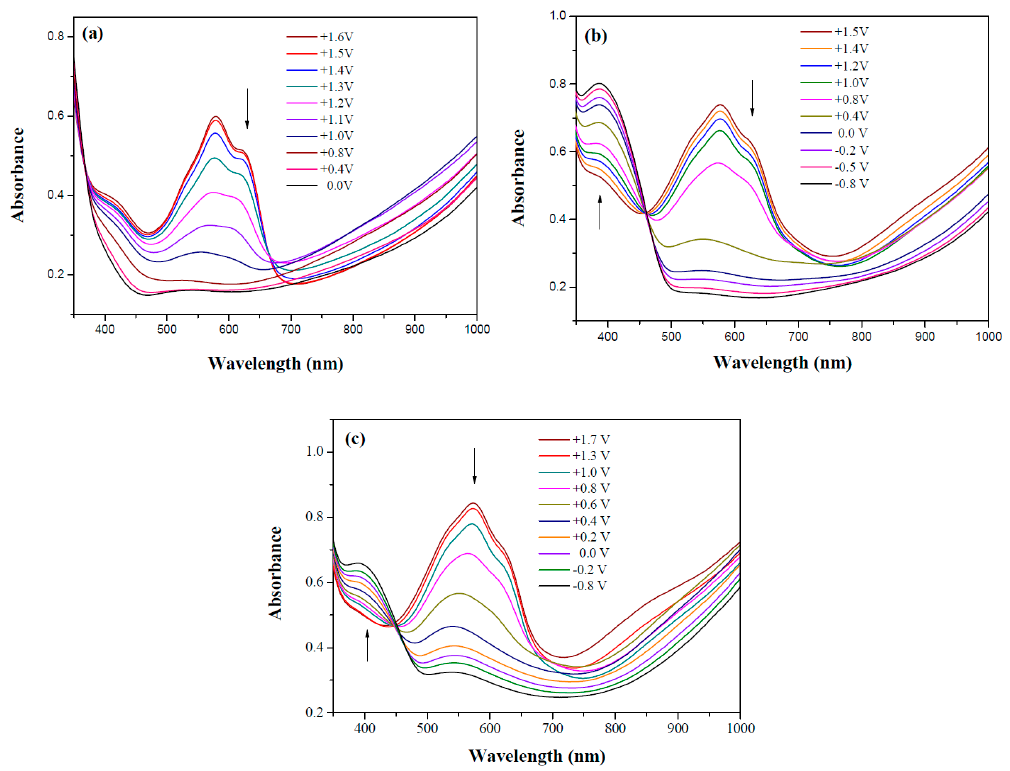
Figure 7. UV-Visible spectra of ( a ) PdCz / PProdot-Me 2 ; ( b ) P(dCz2- co -dTC2) / PProdot-Me 2 and ( c ) PdTC / PProdot-Me 2 ECDs.